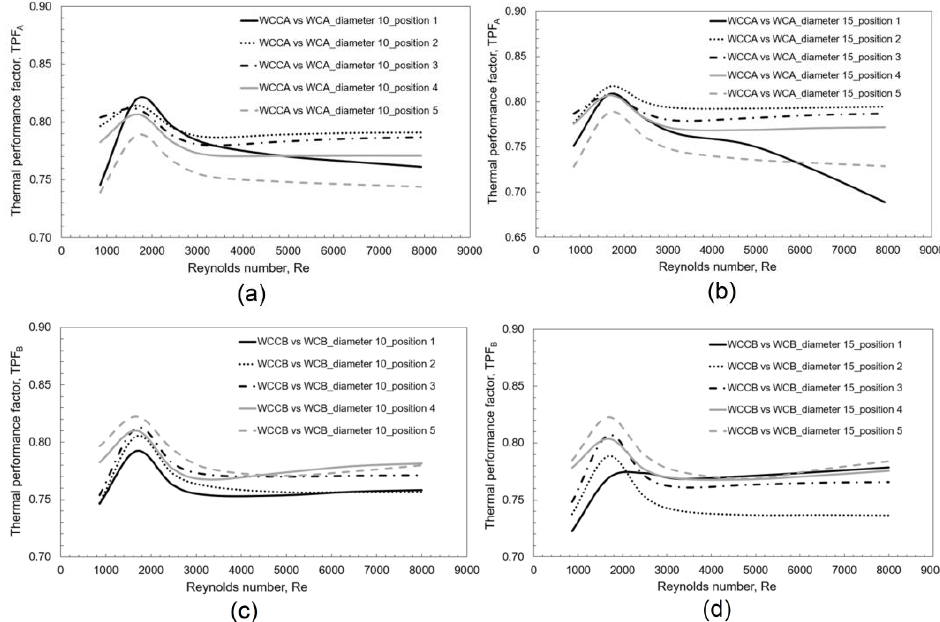
Figure 16. Thermal performance factor for different diameter and CVGs position 1–5, ( a ) WCCA vs. WCA for diameter of 10 mm, ( b ) WCCA vs. WCA for diameter of 15 mm, ( c ) WCCB vs. WCB for diameter of 10 mm, ( d ) WCCB vs. WCB for diameter of 15 mm.